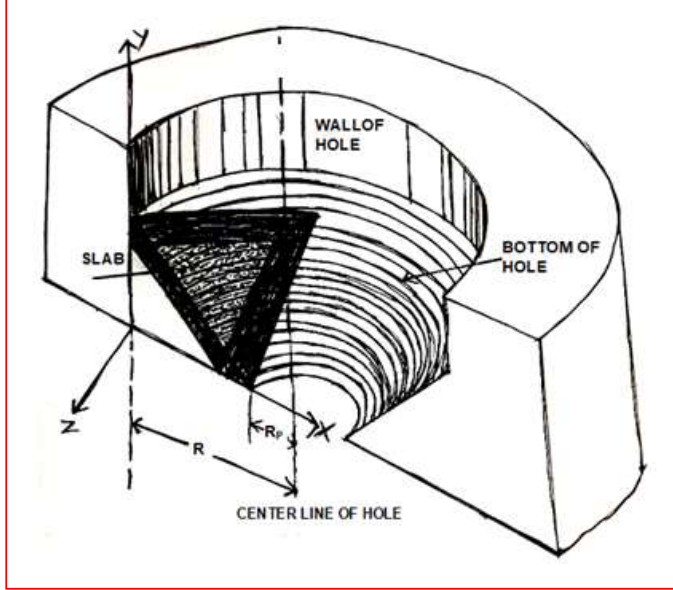
Fig. 5. Burr initiation height